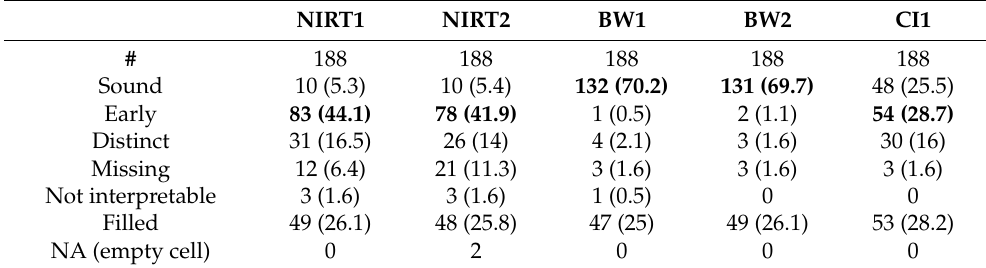
Table 2. Frequency (%) distribution of scores given by the experienced dentists for each diagnostic method for both assessments, (Clinical images (CI), near-infrared transillumination (NIRT), and bitewing radiographs (BW)), including missing, filled, and non-interpretable surfaces. The most relevant results are in bold.